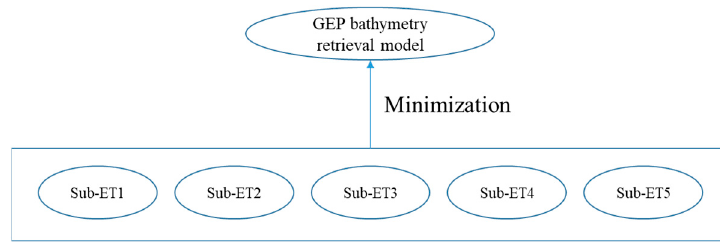
Figure 12. The illustration of the GEP bathymetry retrieval model.